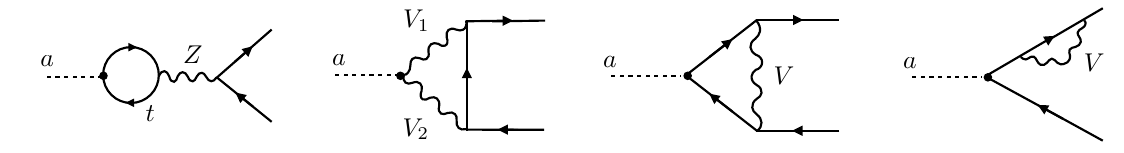
Figure 5 . One-loop matching contributions to the ALP-fermion couplings. In the second diagram ( V 1 V 2 ) = ( WW ) , ( ZZ ) , ( Zγ ) or ( γZ ) . In the last two diagrams V = W, Z , but in the sum of all contributions only the W -boson graphs with internal top quarks (plus the corresponding graphs with Goldstone bosons) give rise to non-zero